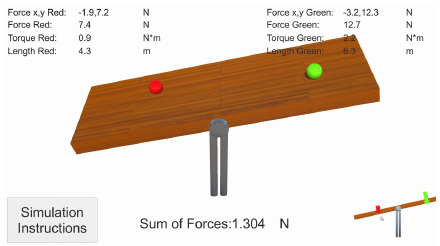
Figure 16. Equilibrium